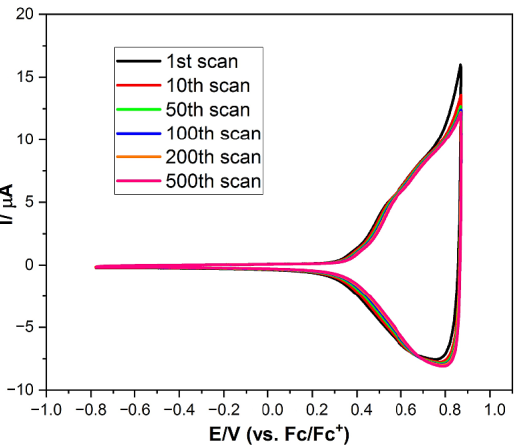
Figure 8. Voltammograms of poly - M3 (polymerization carried out potentiodynamically with upper potential as high as 0.82 V) with sweep rate ν = 100 mV/s, 0.1 M Bu 4 NPF 6 in CH 2 Cl 2 . Only some of the obtained cycles are presented (for clarity).